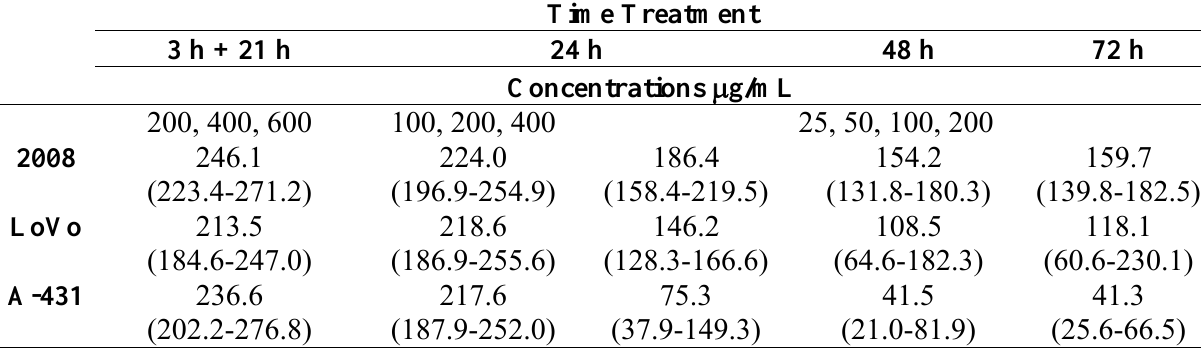
Table 5. IC values and L.C. calculated by exposing 2008, LoVo and A-431cells to R. 50 anthopogon essential oil with different treatment protocols.